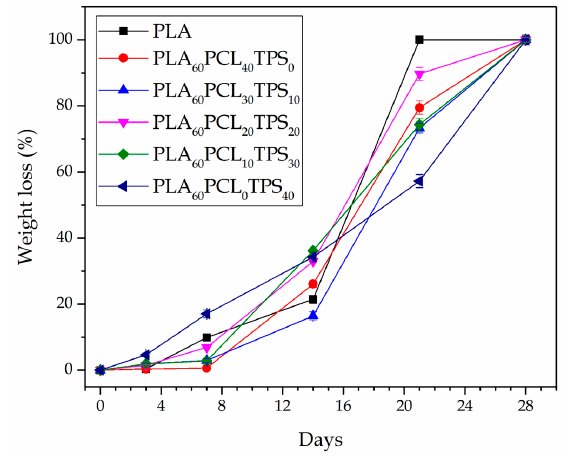
Figure 8. Evolution plot of the percentage of weight loss as a function of the elapsed time during disintegration in controlled compost soil of the polylactide (PLA), poly( ε -caprolactone) (PCL), and thermoplastic starch (TPS) blend pieces.